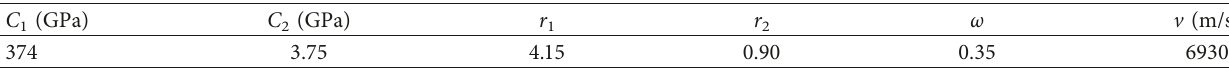
Figure 13: Equivalent 3D model with detonation platform. Table 4: Parameters of